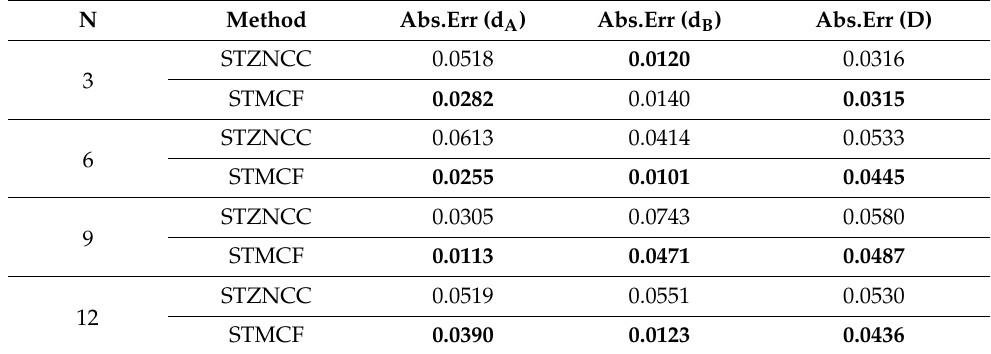
Table 5. Accuracy comparison between STZNCC and STMCF by measuring a dumbbell gauge (Unit: mm).